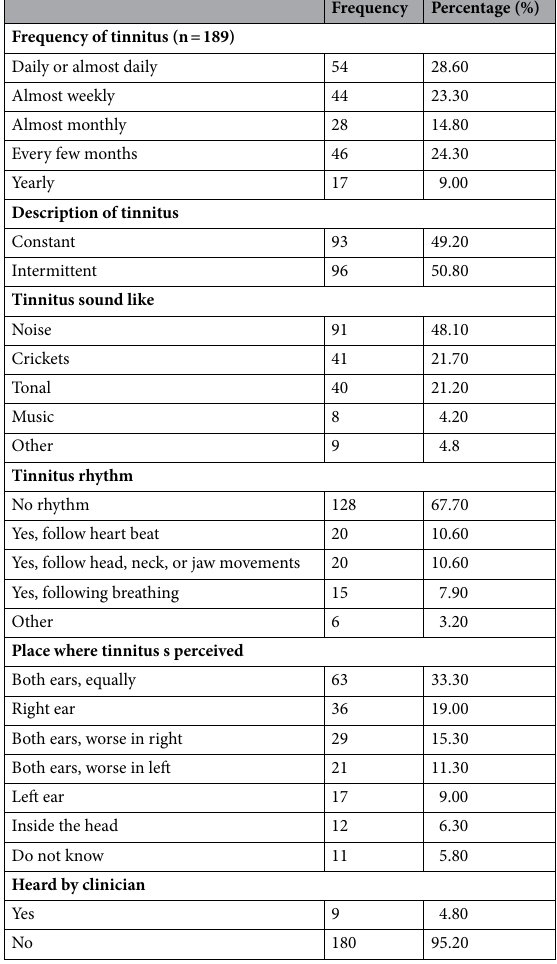
Table 3. Characteristics of tinnitus among the affected participants (n =